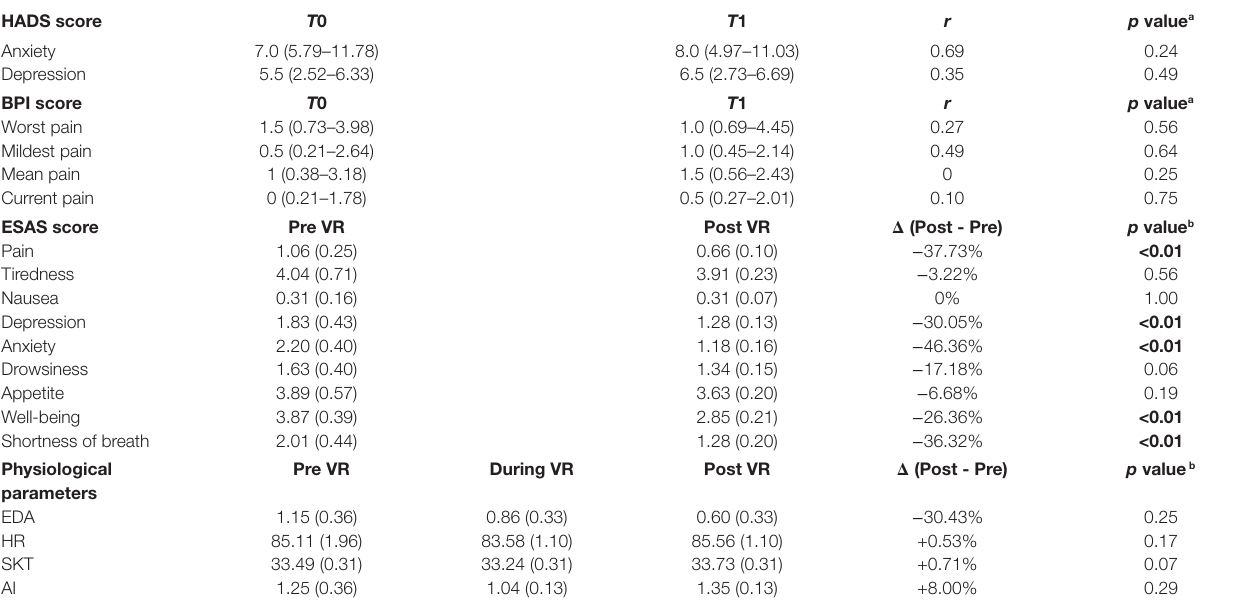
TABLE 3 | Results from the statistical analysis for Hospital Anxiety and Depression Scale (HADS), Brief Pain Inventory (BPI), Edmonton Symptom Assessment Scale (ESAS), and physiological parameters. HADS score T 0 T 1